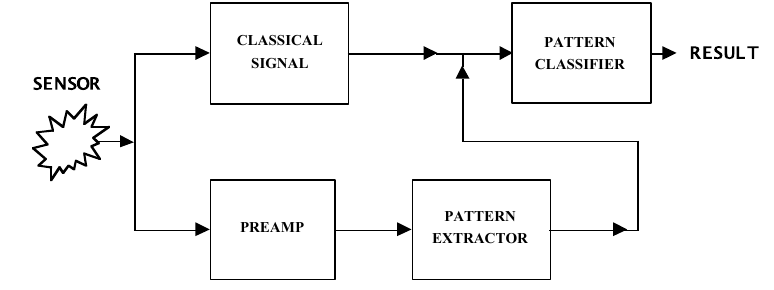
Figure 1. Fluctuation-enhanced sensing scheme.